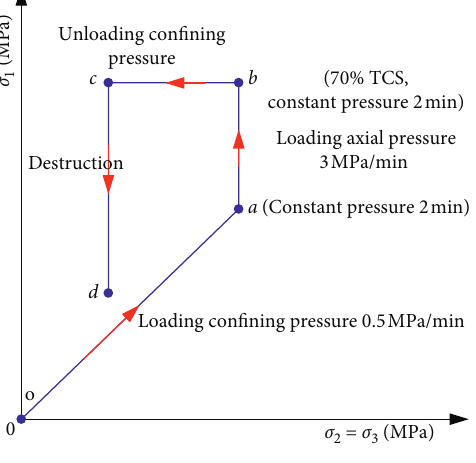
Figure 4: Stress path of lateral unloading test.